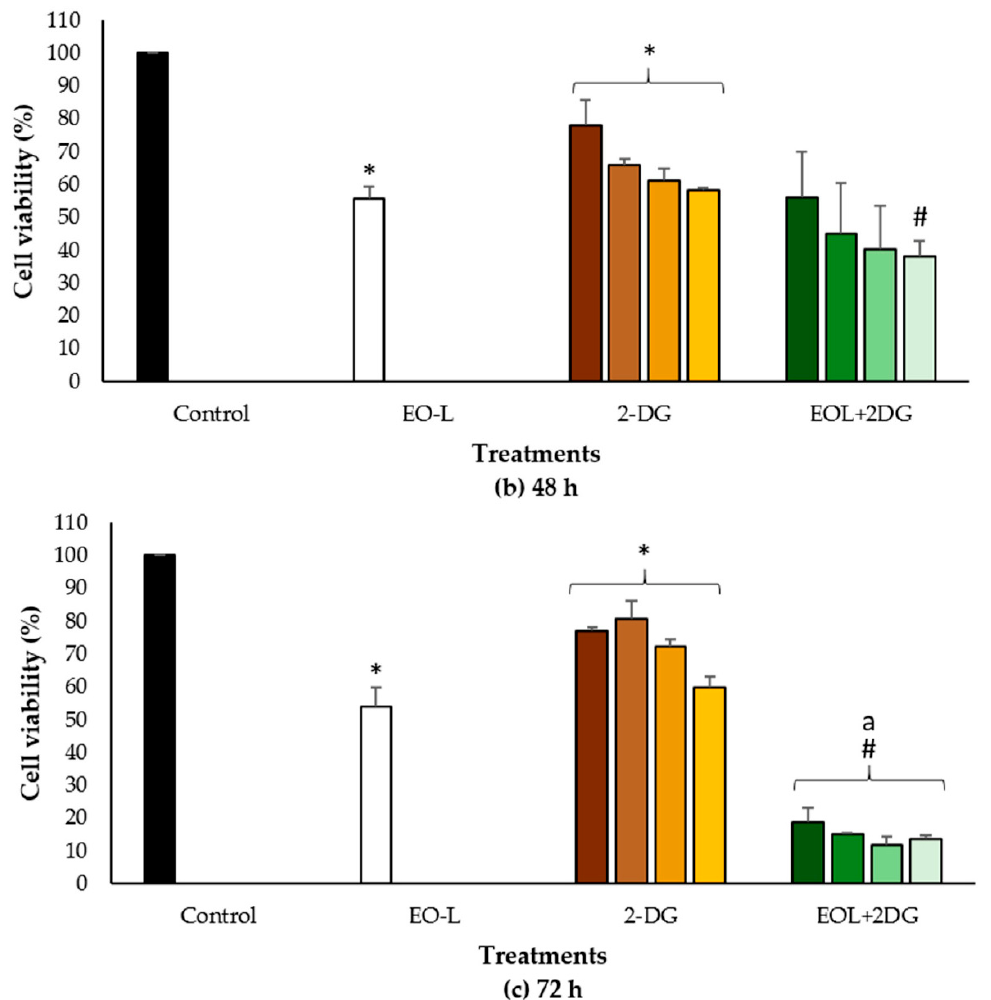
Figure 7. Anti-proliferative effects of EOL+2DG in comparison to untreated, EO-L and 2-DG treatments in PANC-1 cells at ( a ) 24 h, ( b ) 48 h and ( c ) 72 h time points. The data were shown as the mean values ± S.D. for three independent experiments, and the statistical analysis was determined using a Student’s t -test, with the * symbol showing a significant difference ( p < 0.05) in comparison to control untreated cells, the # symbol showing a significance difference ( p < 0.05) in comparison to 2-DG and the a symbol showing a significant difference ( p < 0.05) in comparison to EO-L.